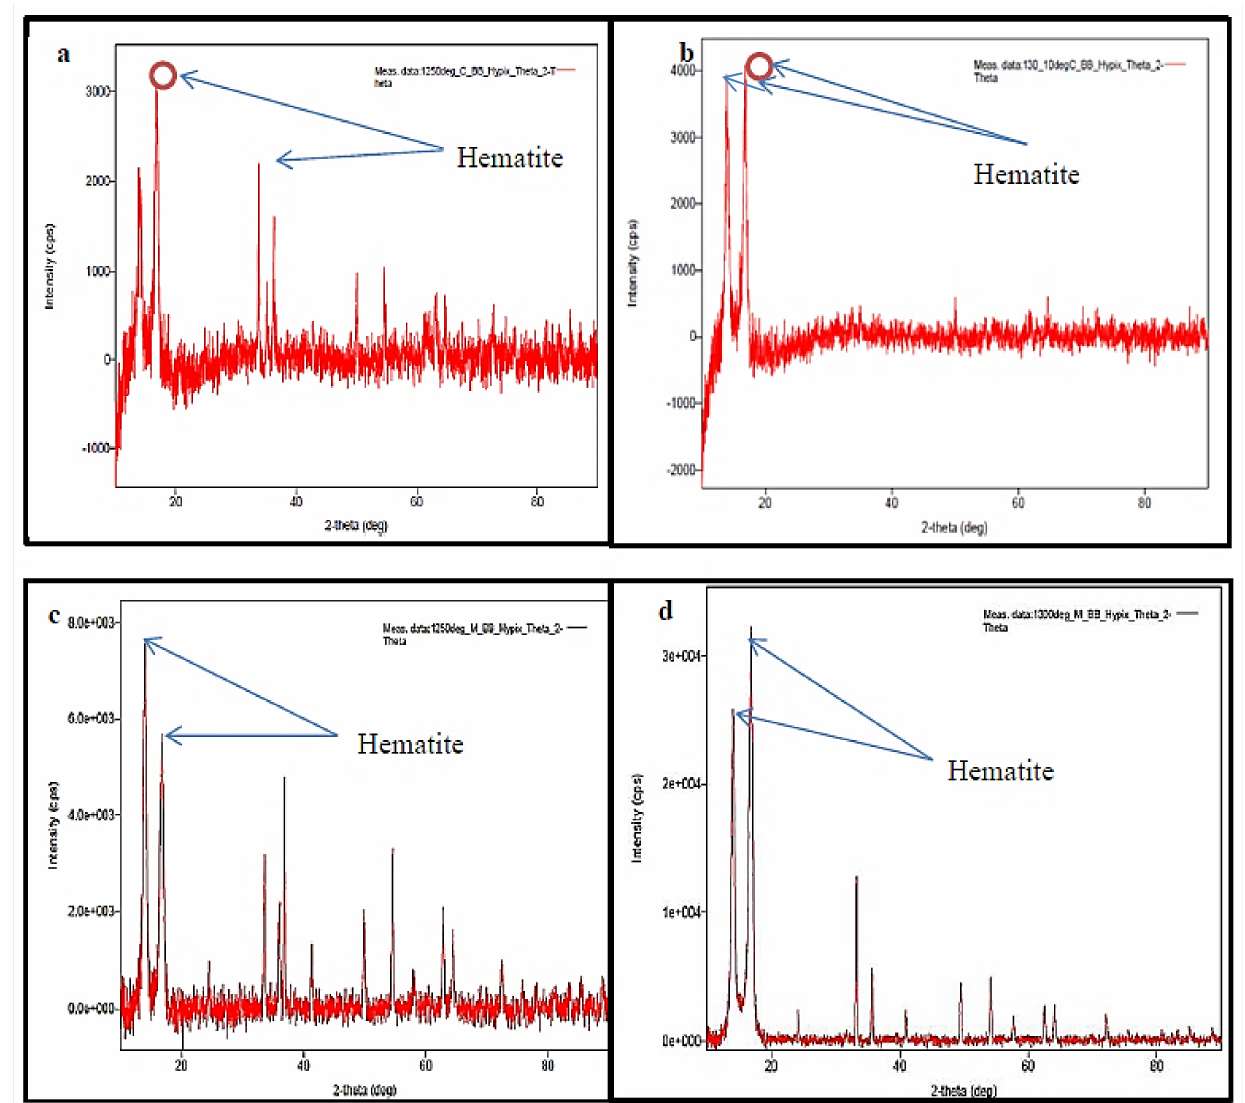
Figure 15. ( a ) Conventionally sintered at 1250 ◦ C, ( b ) conventionally sintered at 1300 ◦ C, ( c ) mi- crowave sintered at 1250 ◦ C, and ( d ) microwave sintered at 1300 ◦